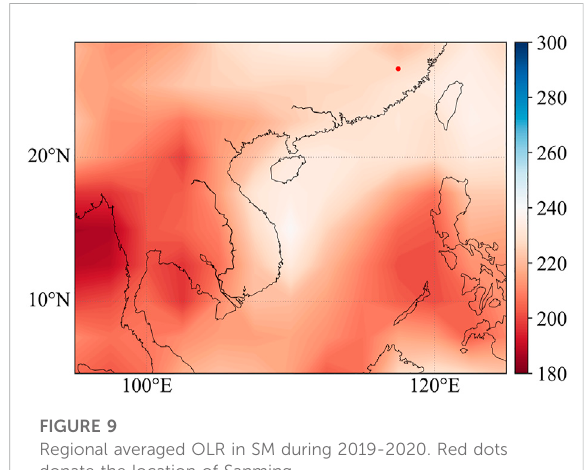
FIGURE 9 Regional averaged OLR in SM during 2019-2020. Red dots donate the location of